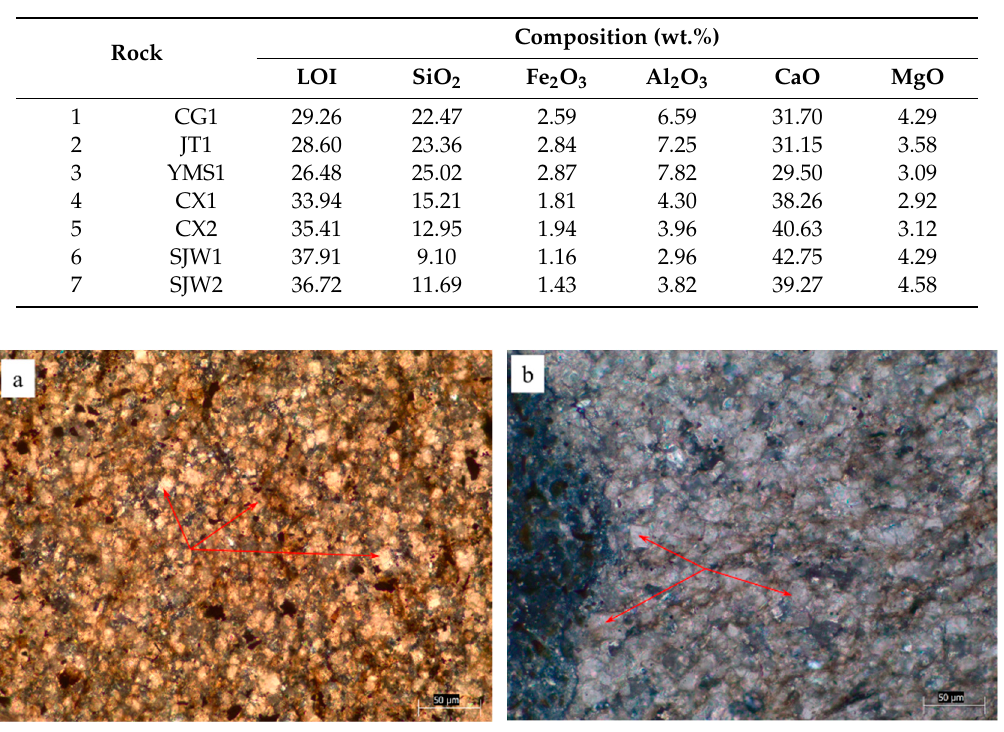
Figure 2. The distribution of dolomite crystals inside YMS1 and CG1 rocks: ( a ) dispersive distribution, ( b ) mosaic distribution. Table 2. Raw material composition of cement clinker without alkali (wt %).